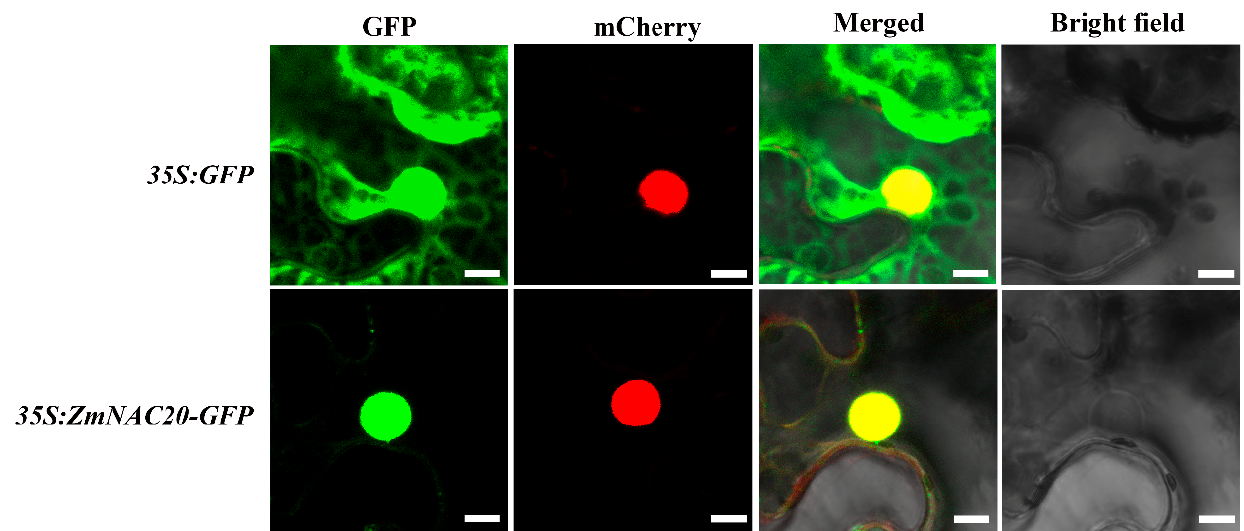
Figure 4. Subcellular localization of ZmNAC20. 35S:H2B-mCherry is a nuclear localization marker. Either 35S:ZmNAC20-GFP or the empty vector 35S:GFP and 35S:H2B-mCherry were co-transfected into leaves of Nicotiana benthamiana . The fluorescence of leaves was imaged using a confocal microscope. The merged signals of GFP and mCherry showed yellow color, suggesting ZmNAC20 was localized in the nucleus. Bars, 10 μ m.